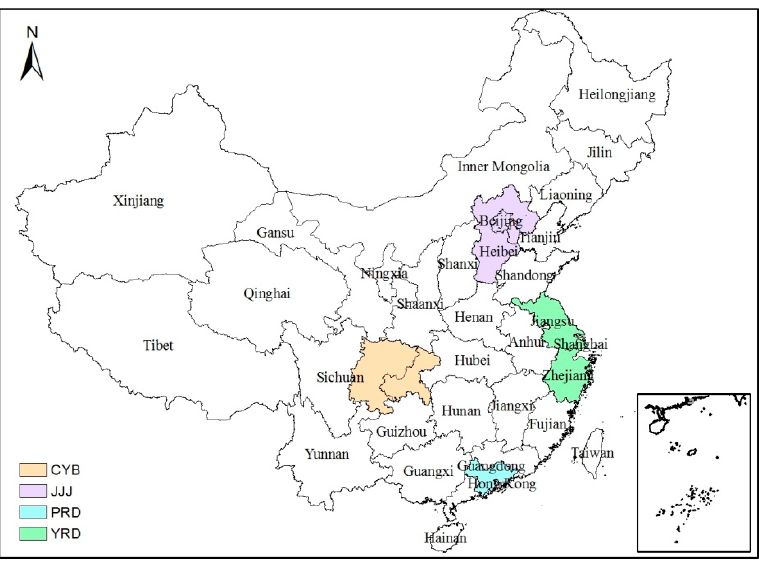
Figure 1. Location map of China and the four regions. Table 1. The proportion of several parameters in key regions.